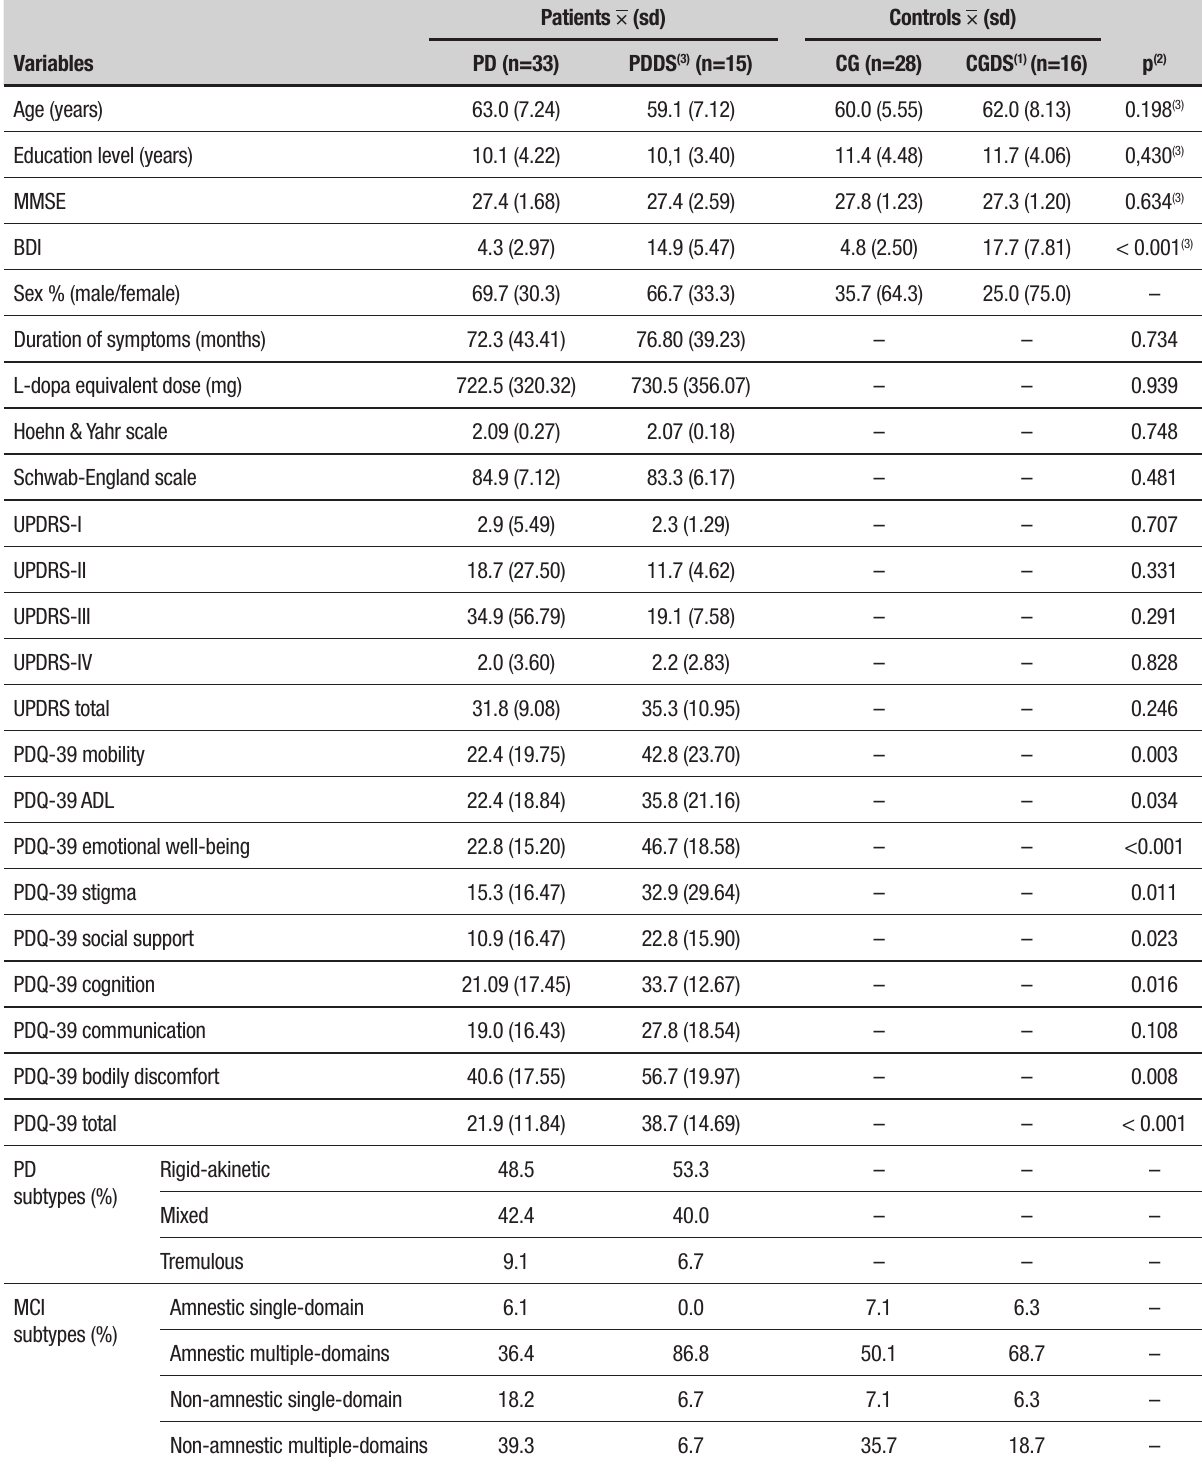
Table 1. Sample characteristics (raw